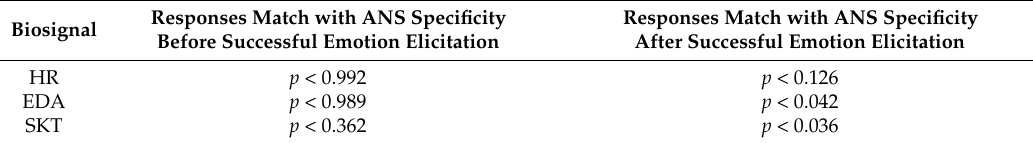
Table 5. Emotional recognition before and after validation of emotion elicitation.